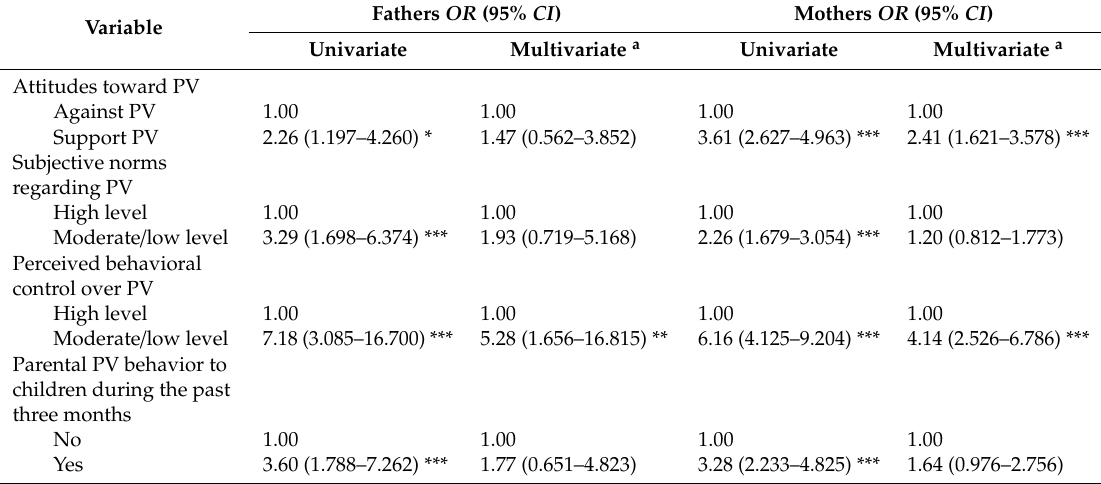
Table 4. Gender disparity in factors that predict parents’ intentions to use PV toward their preschool children in the